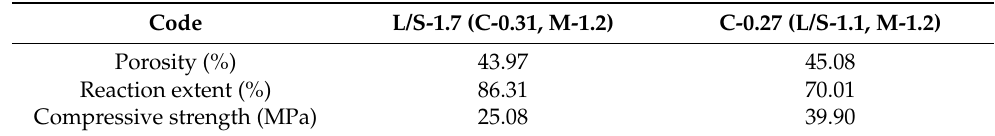
Table 6. Comparison of porosity, reaction extent, and compressive strength between samples L/S-1.7 and